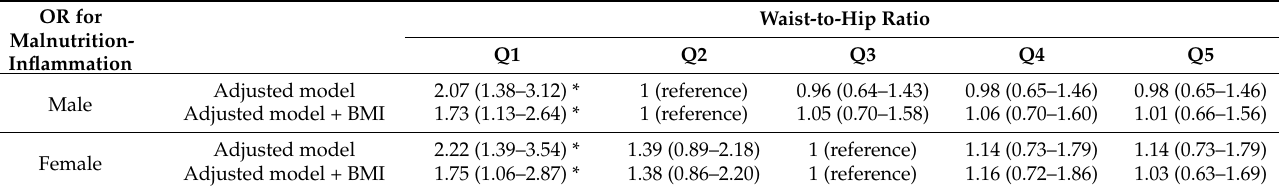
Table 2. Odds ratios for malnutrition–inflammation complex according to WHR.